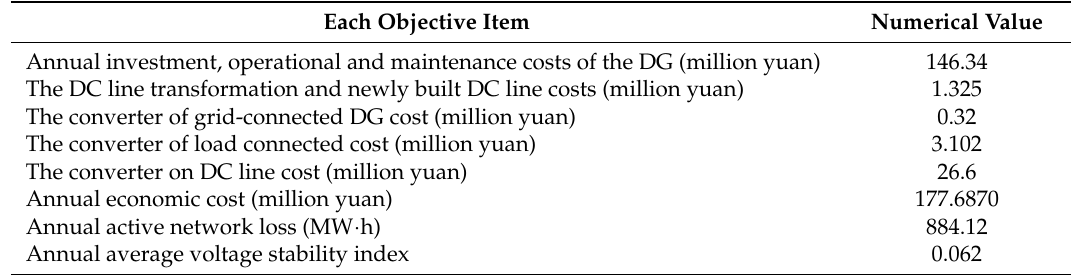
Table 4. The objective function values when considering DC line transformation and newly built DC line. Each Objective Item Numerical Value